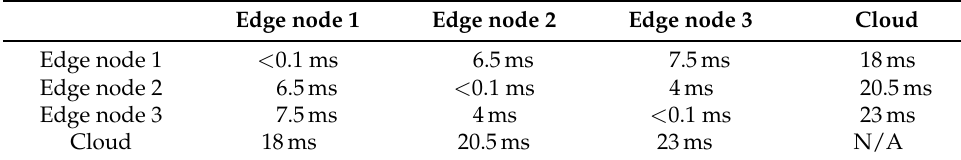
Figure 9. Experimental edge and network setup with three edge nodes and connection to the cloud. Table 1. Round-trip times between endpoints in the test